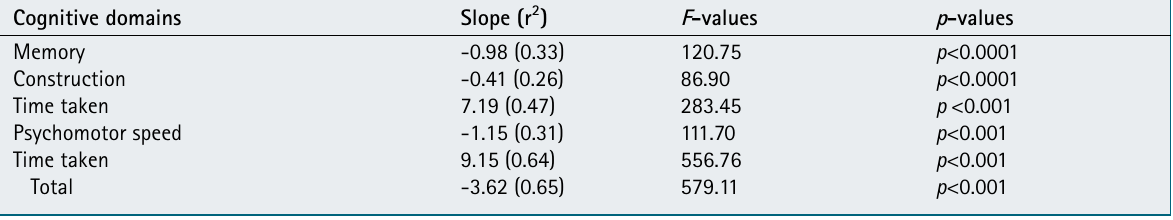
taBle iV. tHe coMPariSon oF cognitiVe PerForMance WitH cD4+ leVelS USing tHe F-teSt For linear trenD